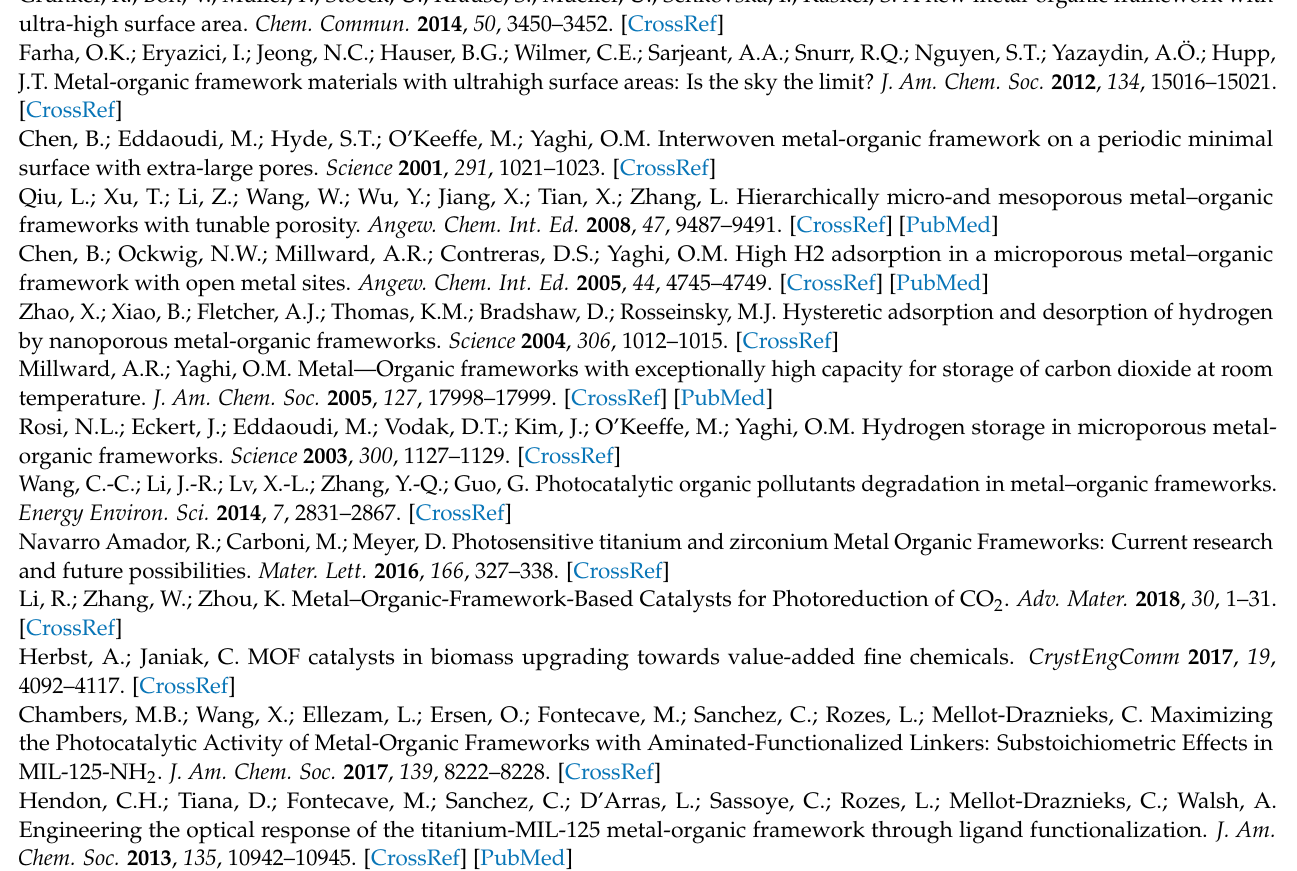
propylene carbonate, Figure S4: 13 C NMR spectrum for obtained propylene carbonate, Figure S5: FTIR spectrum for obtained propylene